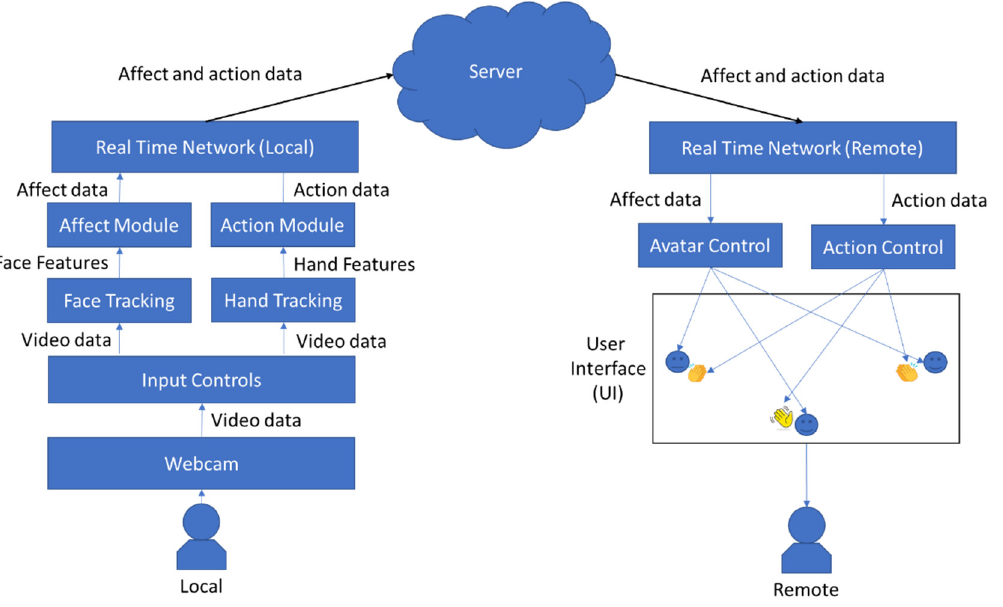
Figure 10. The proposed natural and affective virtual conference application.